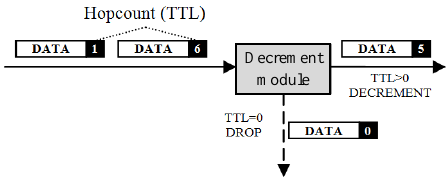
Figure 8. Hop count effect on processed packets, showing decrement and drop if zero.